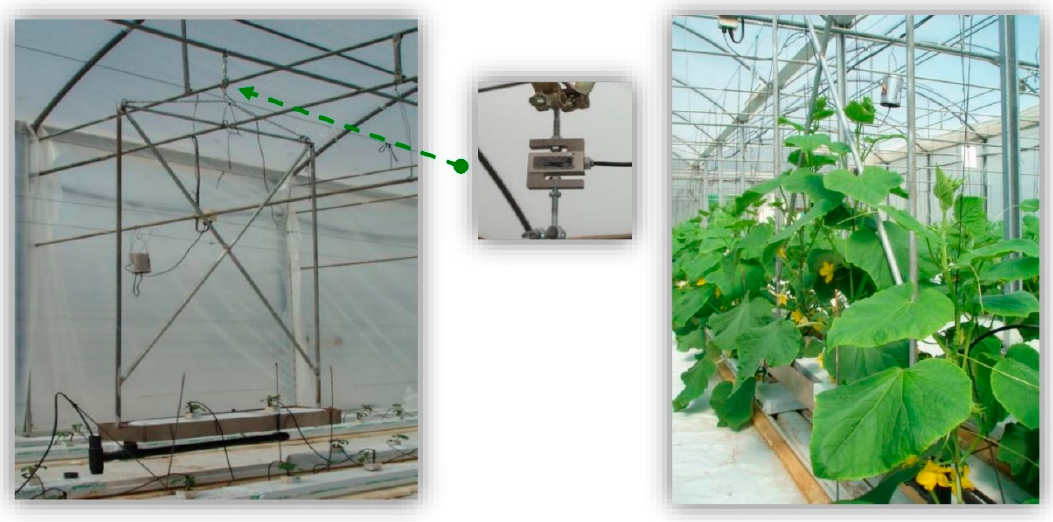
Figure 3. Mounting a lysimeter in a greenhouse structure (left), weighing device S-Beam load cell (centered) and plants grown in a lysimeter (right).